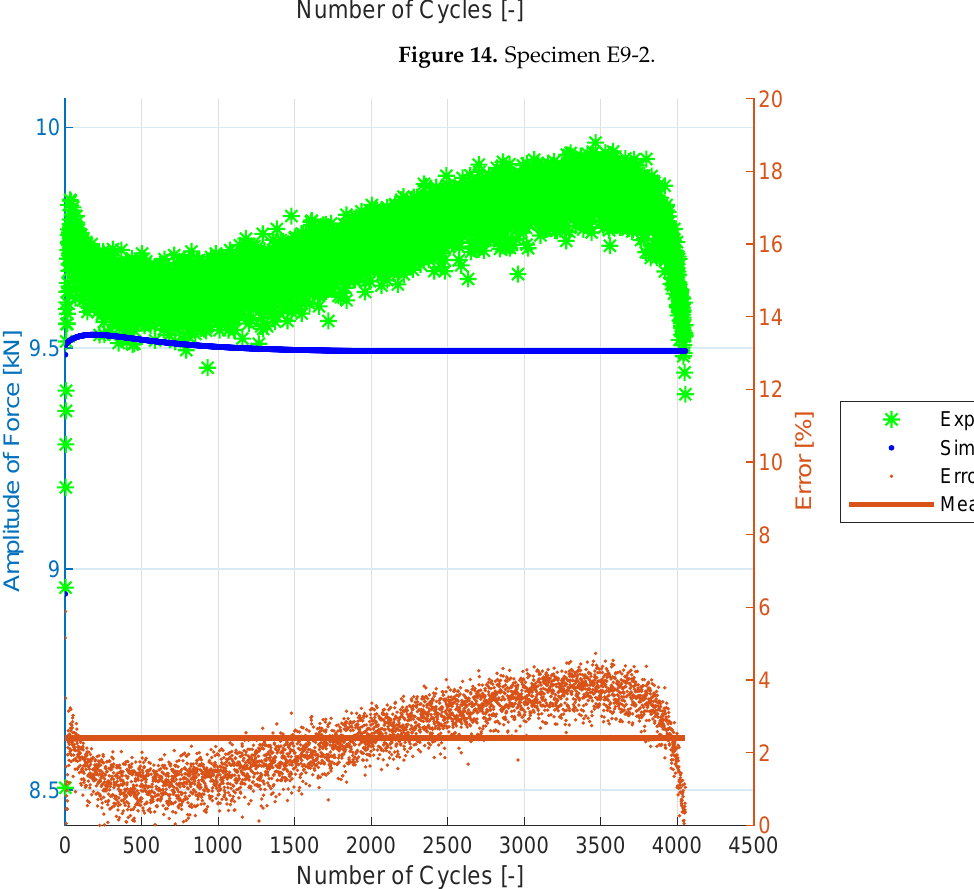
Figure 14. Specimen E9-2.